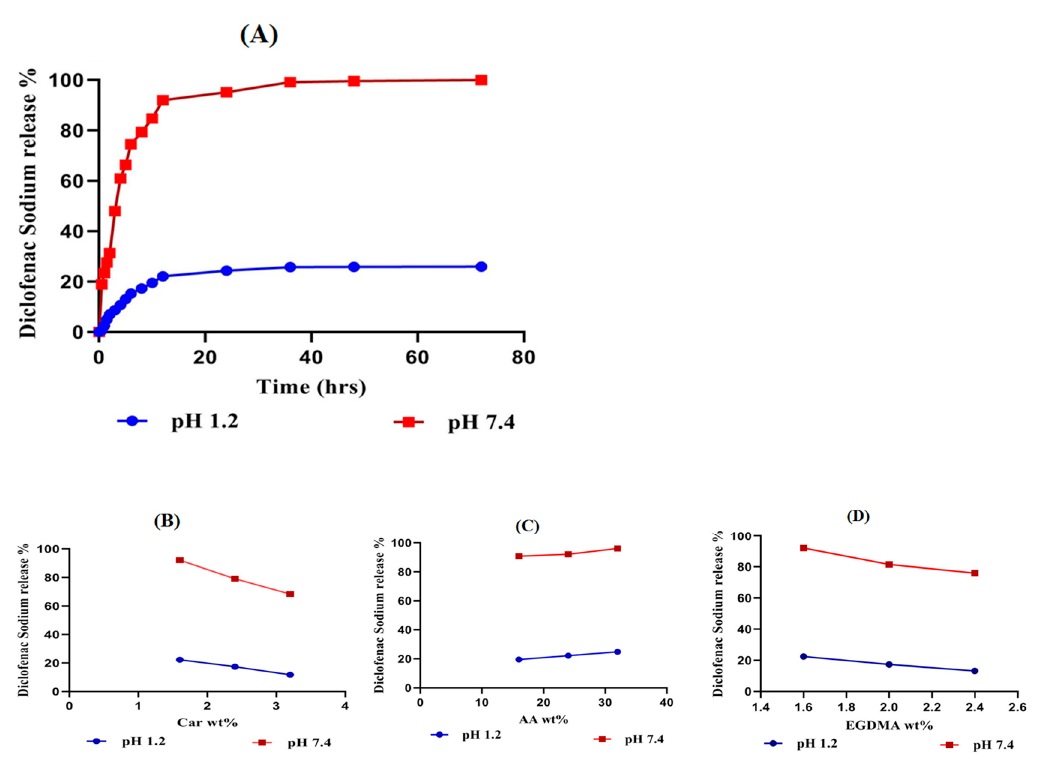
Figure 9. ( A ) Effects of pH on the diclofenac sodium percent release from Car934-g-poly(acrylic acid) hydrogels. ( B ) Effects of carbopol, ( C ) Effects of AA and ( D ) Effects of EGDMA on the diclofenac sodium percent release.